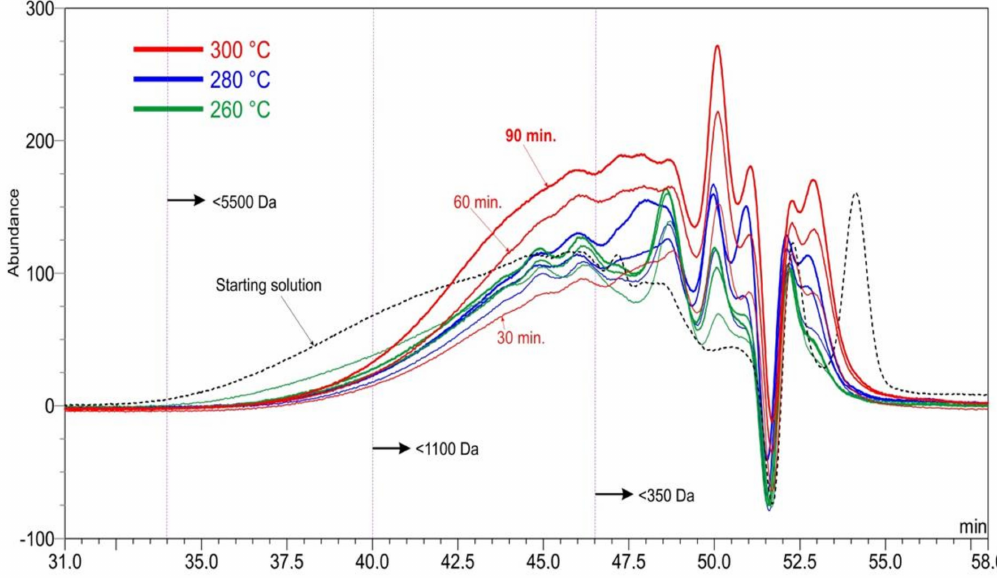
Figure 12. Chromatograms at the wavelength of 214.4 nm by HPLC with GPC column before (dashed line) and after hydrocracking at different temperatures and residence times (colored